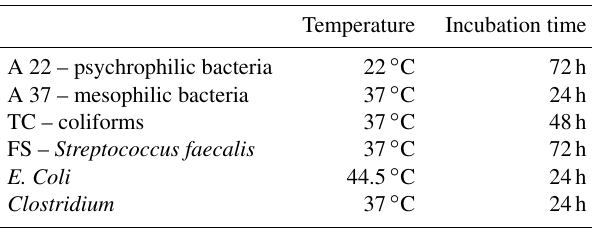
Table 1. Temperature and incubation time for determinations of in- dividual groups of